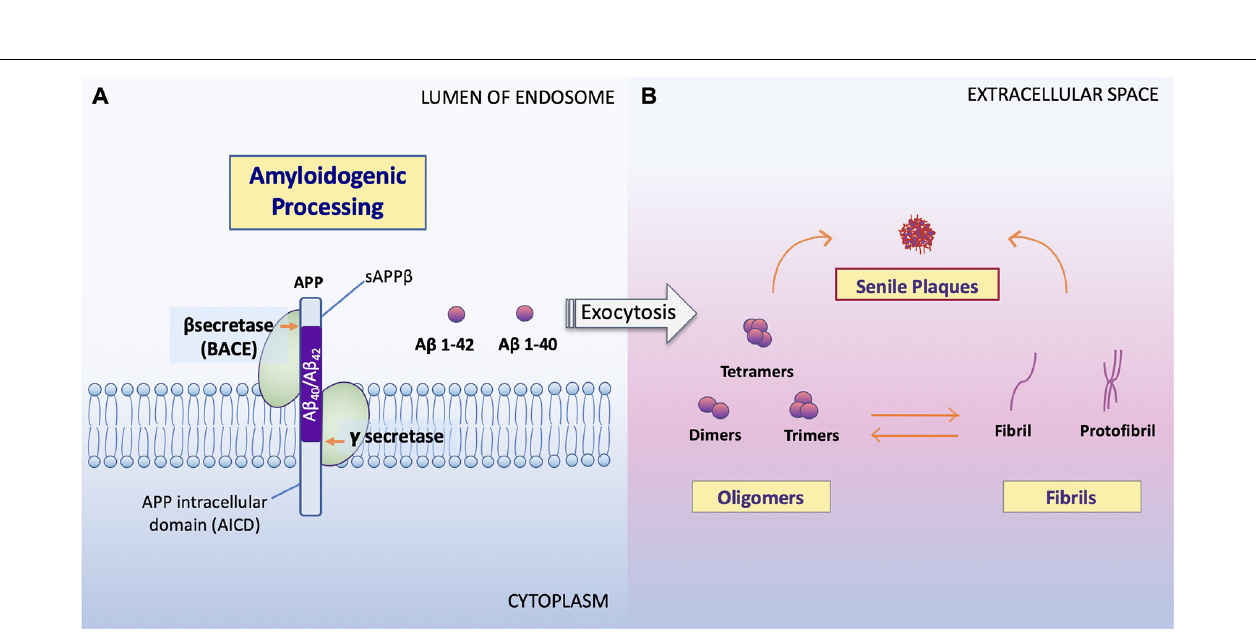
Frontiers in Molecular Neuroscience |